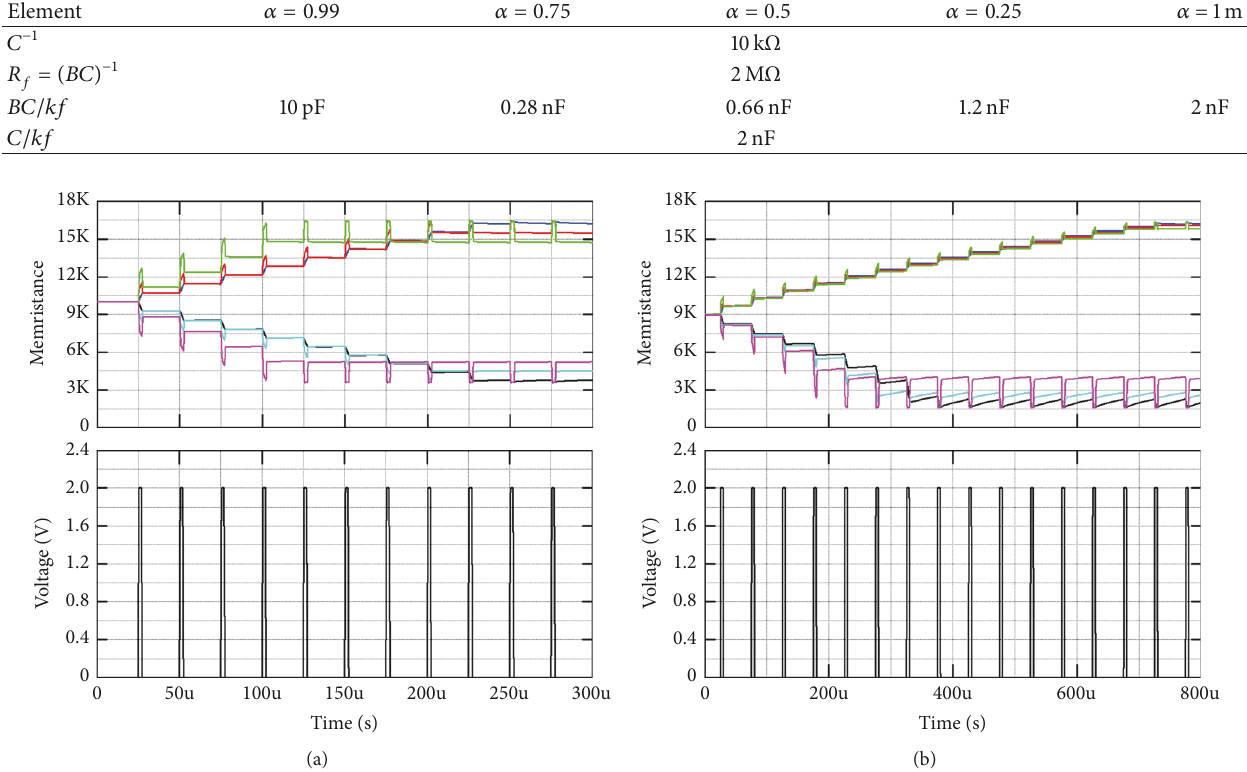
Figure 7: Incremental and decremental fracmemristance variation when a pulse train (bottom graphics) is applied to (a) Figure 4(a) and (b) Figure 4(b). For the incremental case: 𝛼 = 0.99 (light blue line), 𝛼 = 0.75 (light red line), and 𝛼 = 0.5 (light green line). For the decremental case: 𝛼 = 0.99 (black line), 𝛼 = 0.75 (light cyan line), and 𝛼 = 0.5 (light magenta